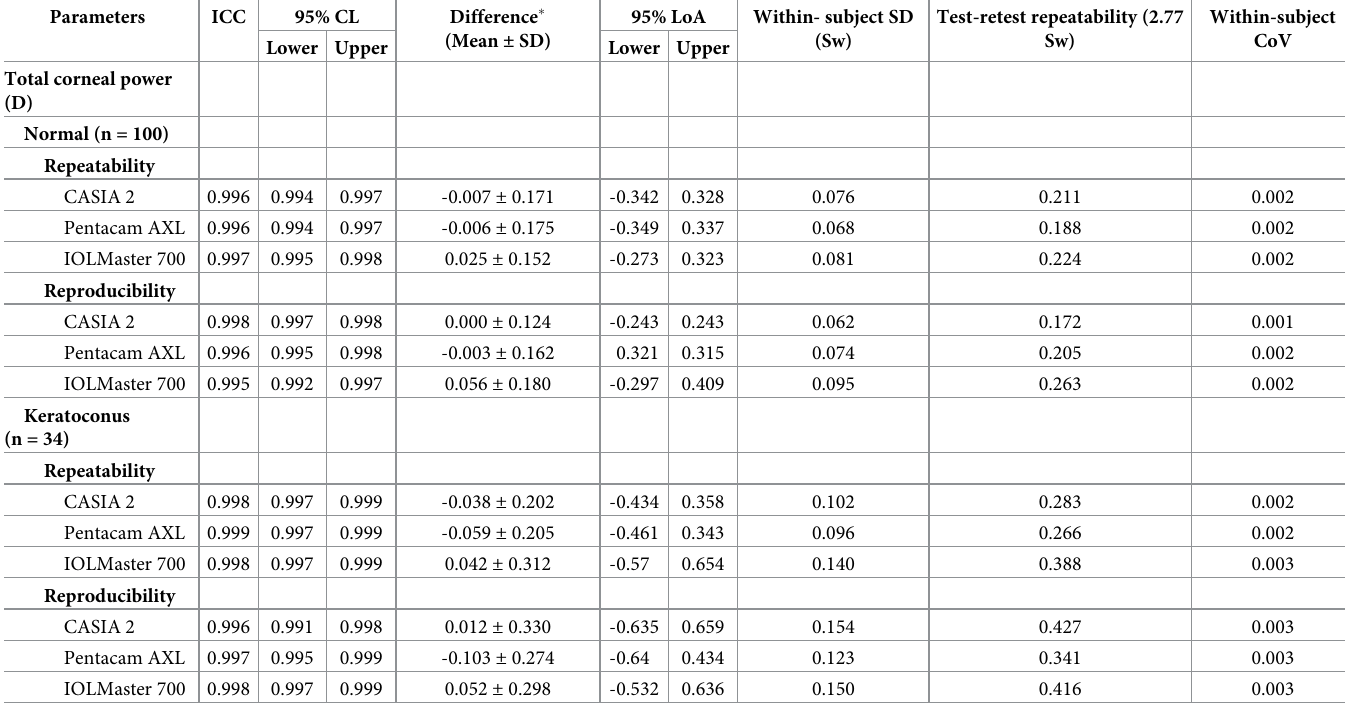
Table 4. Repeatability and reproducibility of total corneal power in normal and keratoconus participants.